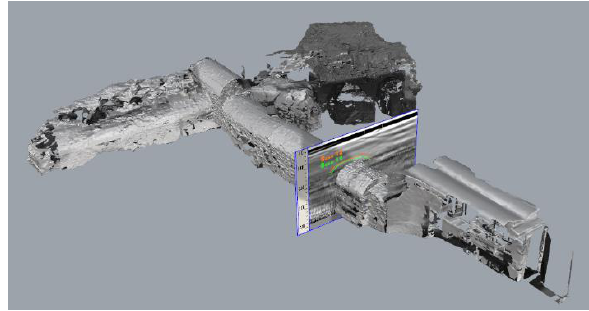
Figure 5. Laser scanning data and ground penetrating radar data.